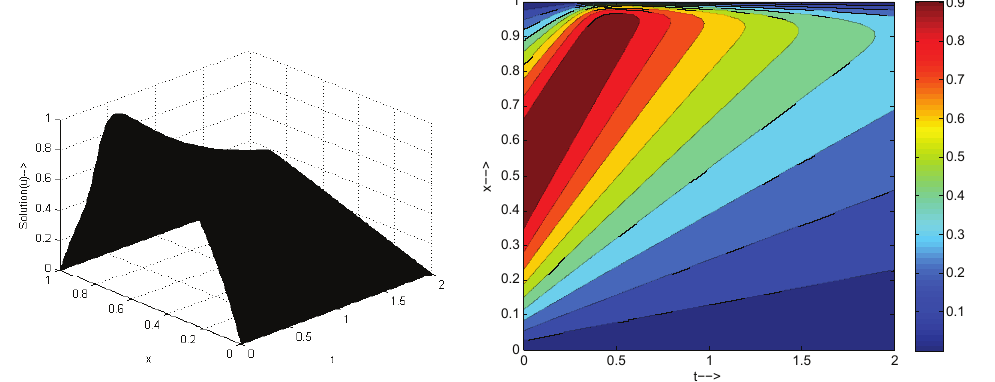
Fig. 8: Physical behavior of numerical solutions of Example 2 at different times in 3D and contour for Δx = 0.0125 , ν = 0.01 at different times with Δt = 0.001 .